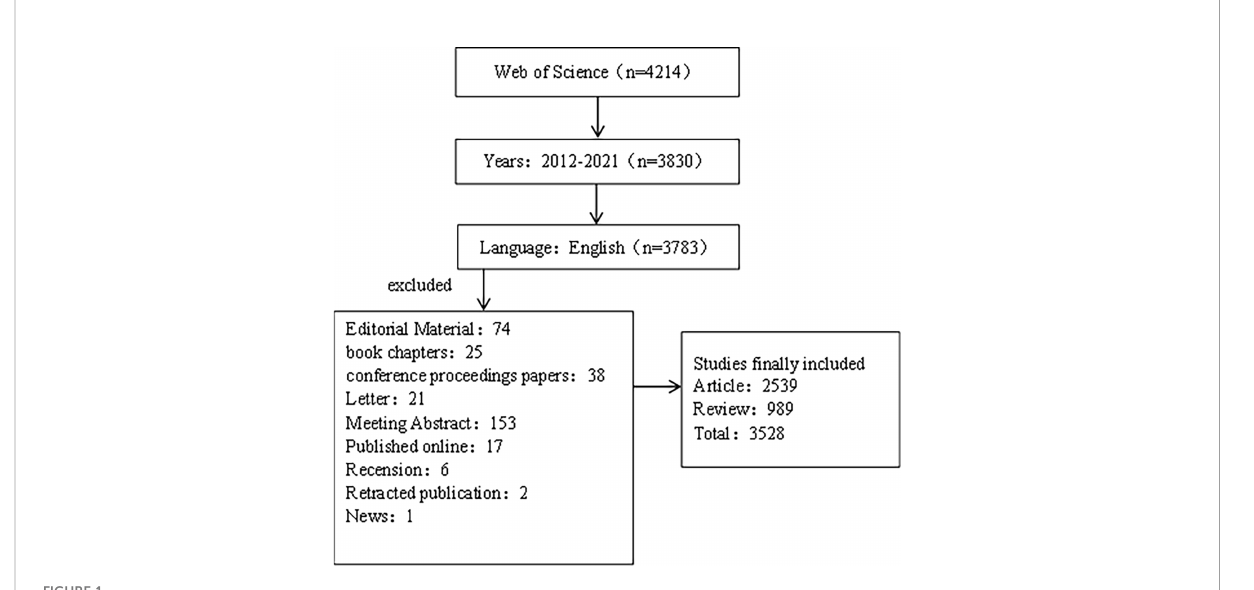
FIGURE 1 Flowchart for including and excluding literature